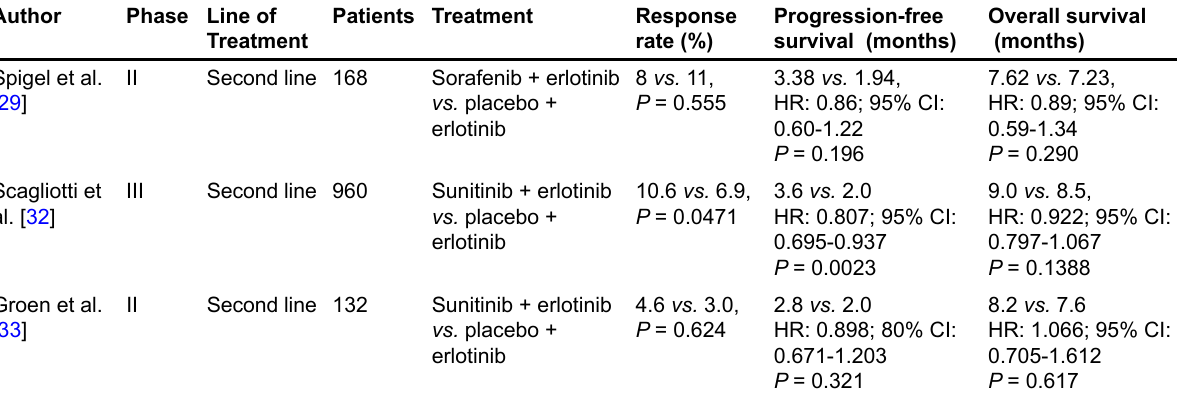
Table 2. Oral VEGFR inhibitors and erlotinib in EGFR wild type NSCLC